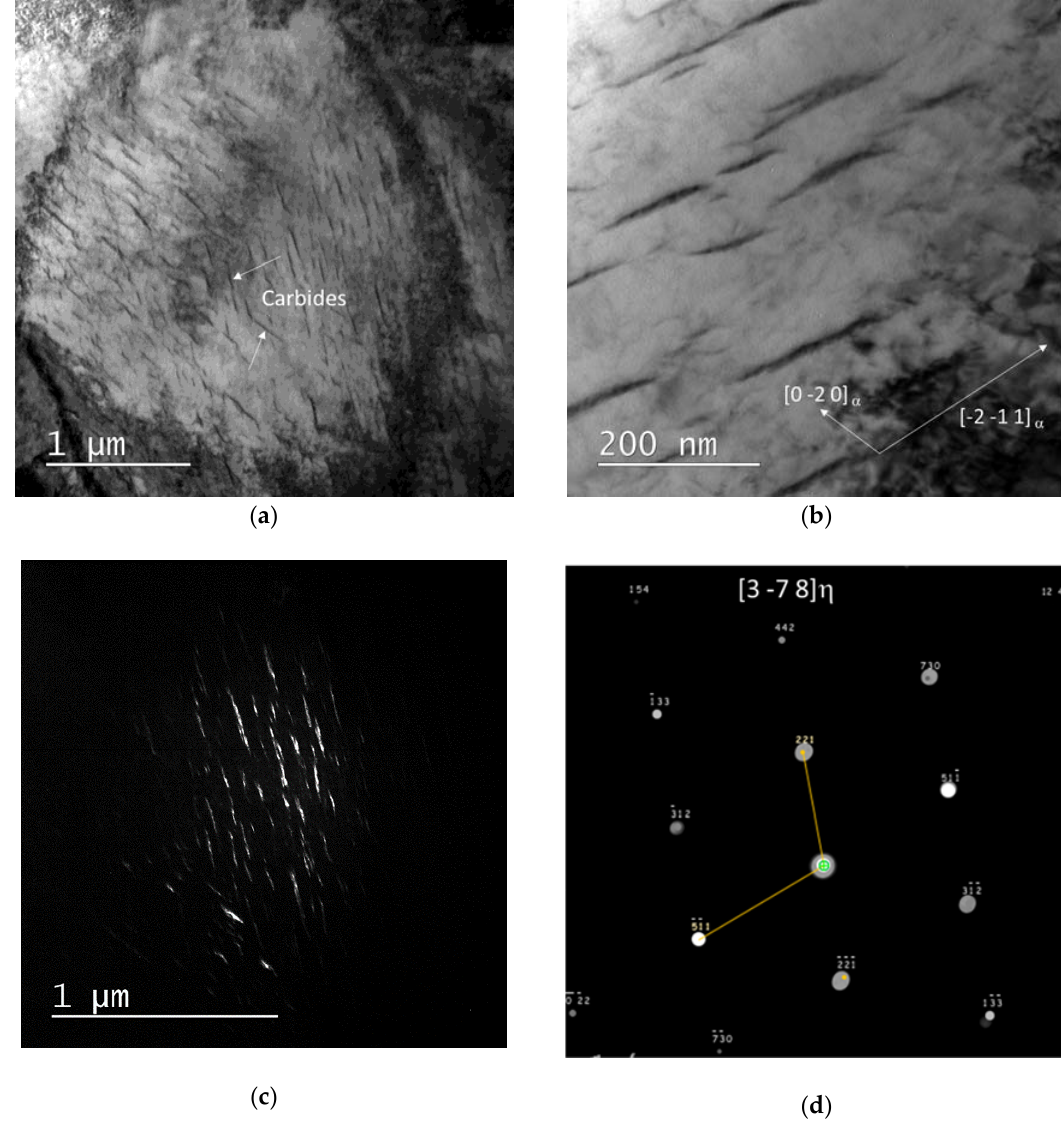
Figure 3. ( a ) Bright field transmission electron microscopy (BF TEM) micrograph of the studied steel after Q&P heat treatment (state 8). Arrows highlight the presence of 2 variants of carbides (dark contrast) in the tempered martensitic matrix (wide block). ( b ) BF TEM micrograph of the studied carbides aligned along martensite [-2-11] α ’ (zone axis [210] α ’ ). ( c ) Dark field (DF) image using (111) η spot. ( d ) Indexed diffraction pattern (zone axis [3-78] η ) of the η carbides aligned along martensite [-2-11] α ’ .